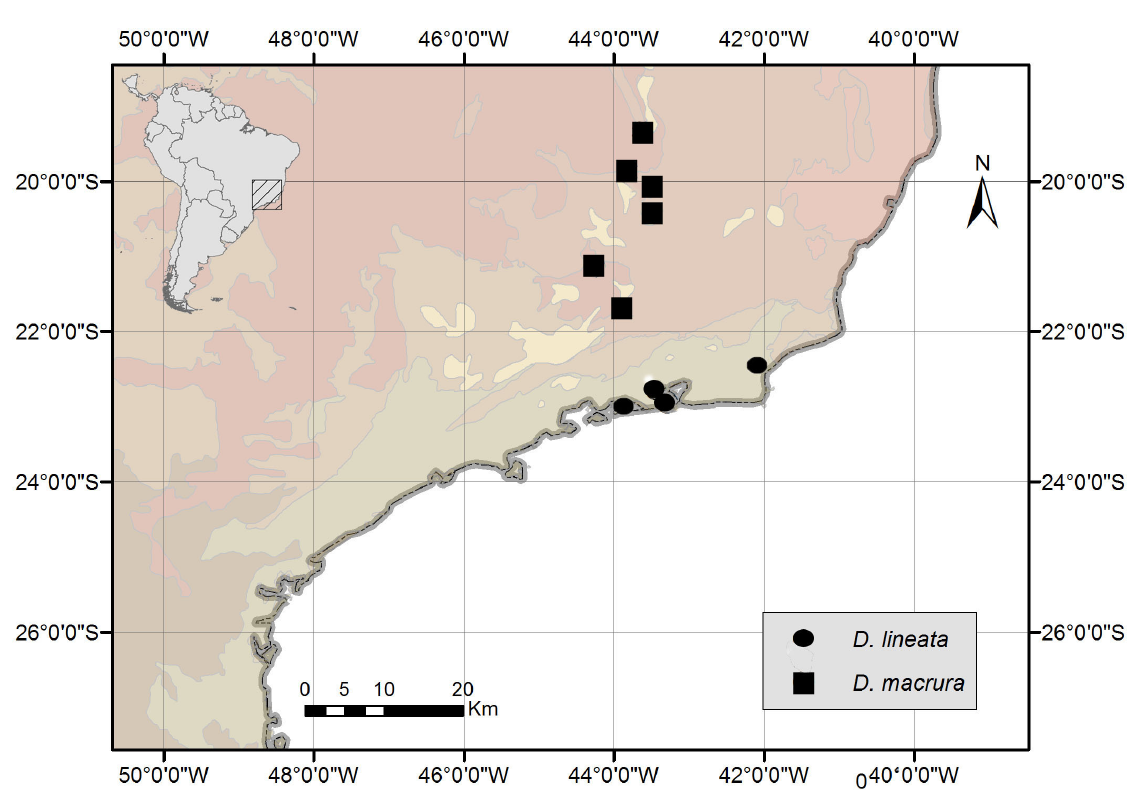
Fig. 26. Map showing the known records of Diplura macrura (C.L. Koch, 1841) and Diplura lineata (Lucas,